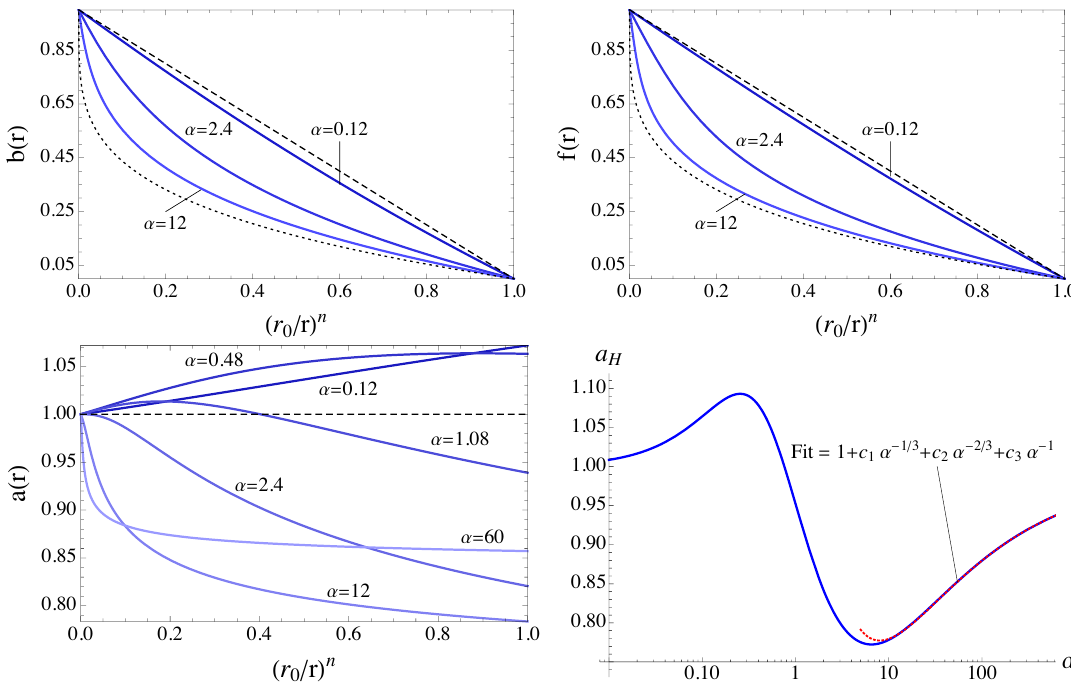
Figure 2 . Metric functions in n = 4 ( d = 8 ). GR and pure GB black strings correspond to the black dashed and dotted curves respectively. a which eventually goes back to a